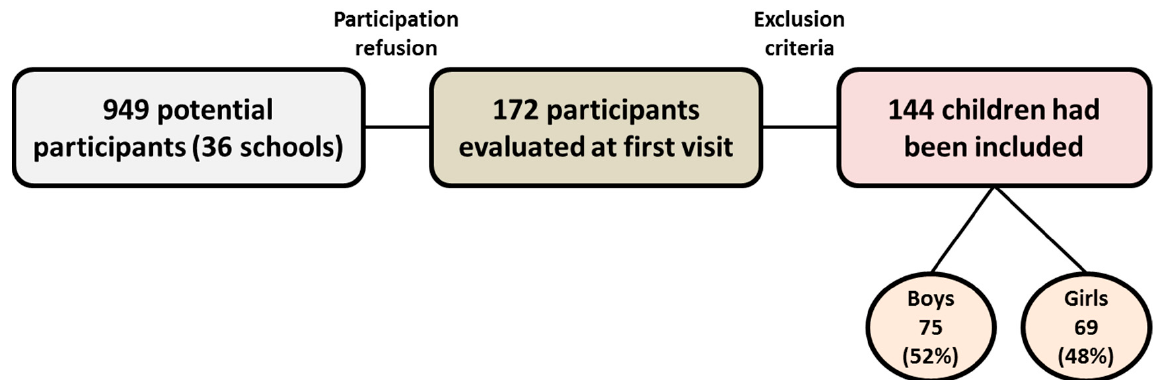
Figure 1. Screening and follow-up of studied metabolically healthy prepubescent population with obesity. From these 144 participants, 75 (52%) were male and 69 (48%) female ( p = 0.62), with an average age of 7.8 ± 1.4 years. All families presented a low–middle socioeconomic status (97.3%), with 42.3% of them showing a medium–high educational level and 57.7% of them a low